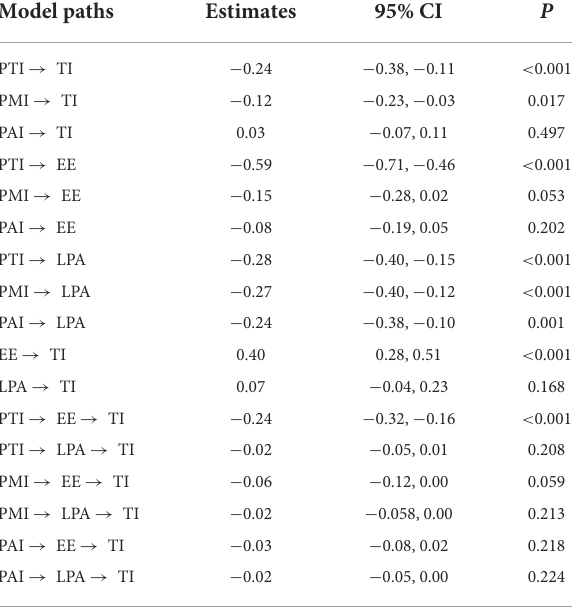
TABLE 5 Standardized effects of model paths. Model